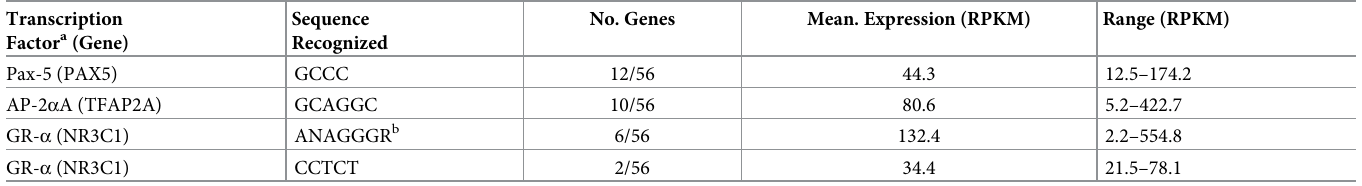
Table 4. Transcription factor recognition sequence near TSS in the promoters of database human testis-specific genes. Transcription Factor a (Gene)